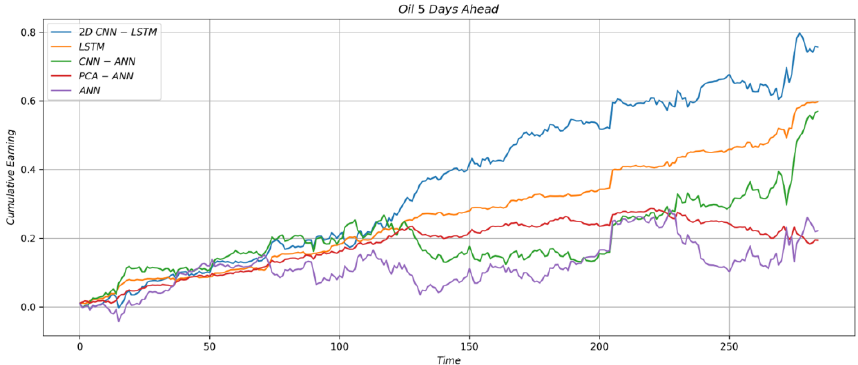
Figure 13. Comparison Of Cumulative Trading Profit with Five-Day-Ahead.